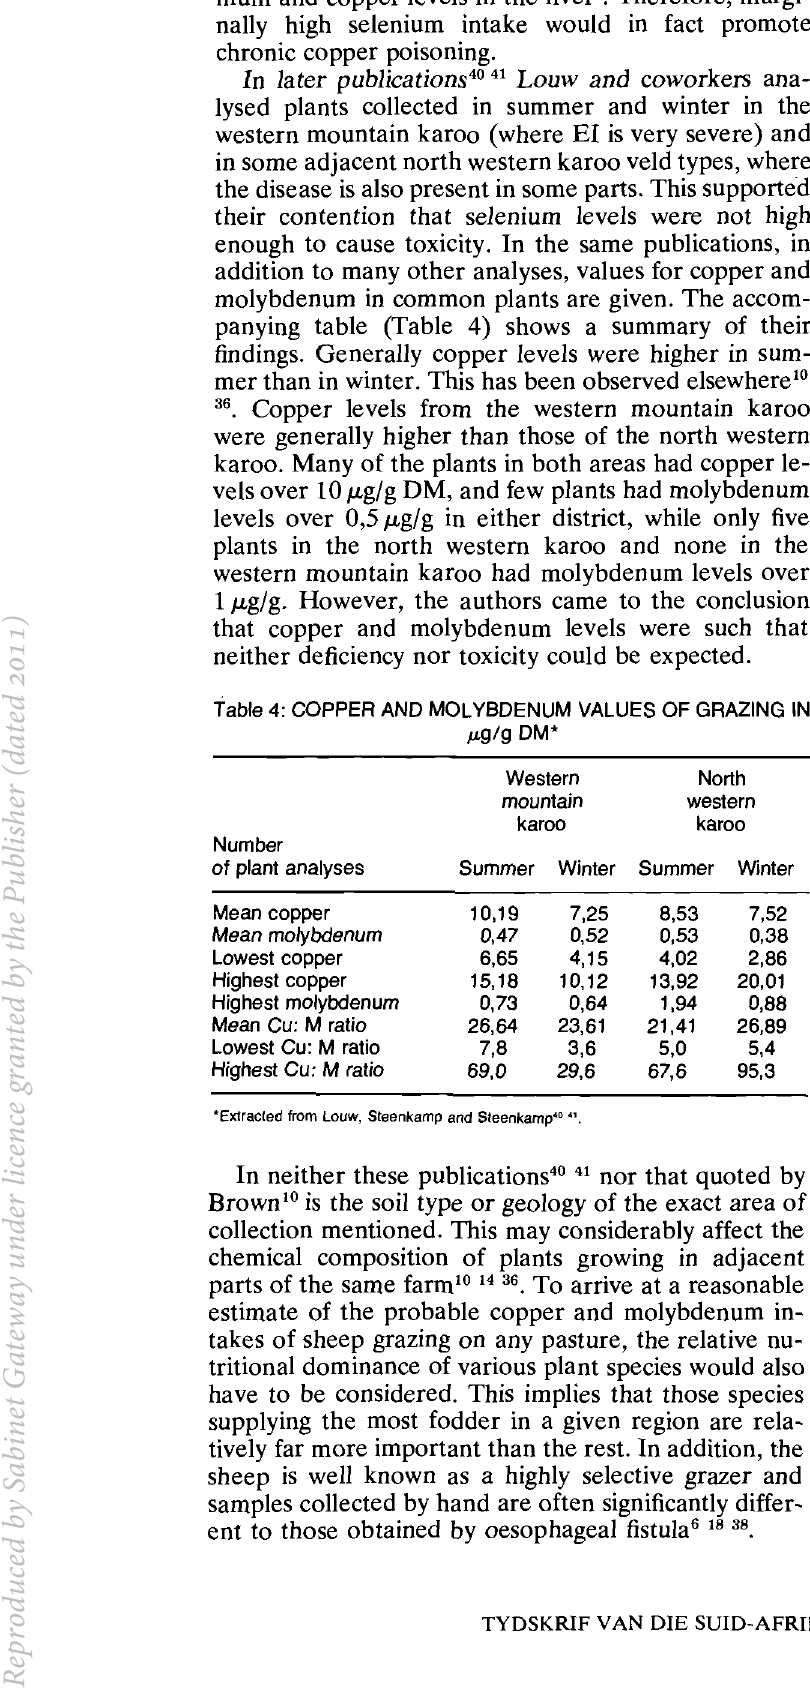
Number of plant